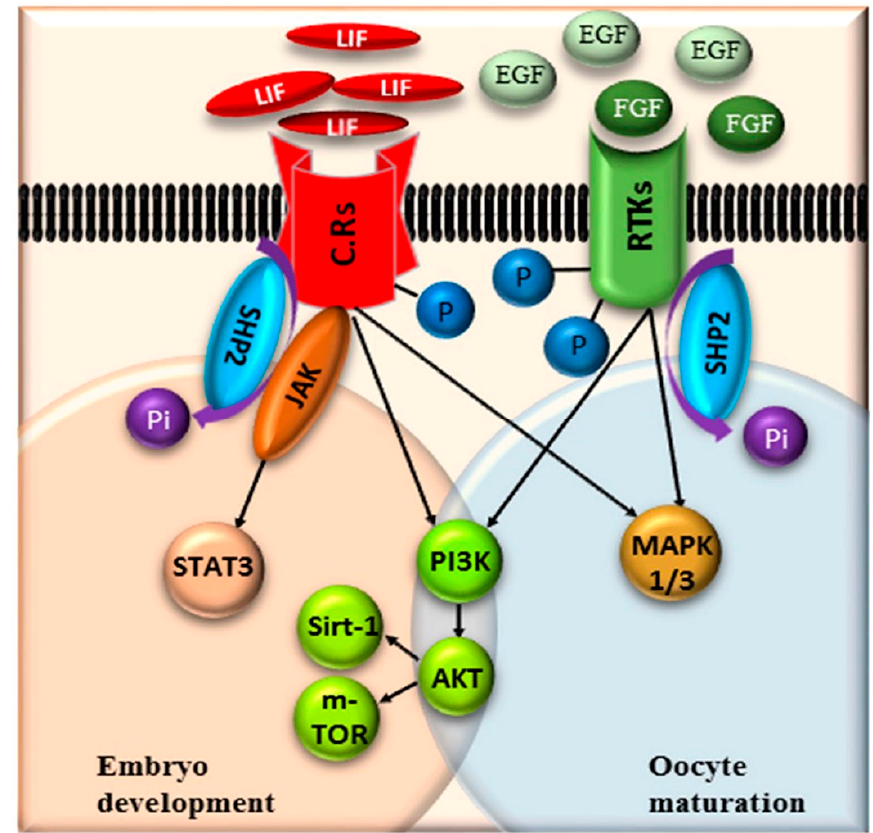
Figure 6. Schematic representation of the potential pathway for SHP2 de-phosphorylation of receptor tyrosine kinases (RTKs) and cytokine receptors (CR) in oocytes and blastocysts. Upon ligand binding these receptors are hyper-phosphorylated and SHP2 de-phosphorylate them by taking phosphate group, as a result the adaptor proteins get attached to the receptors and signal transduction starts.